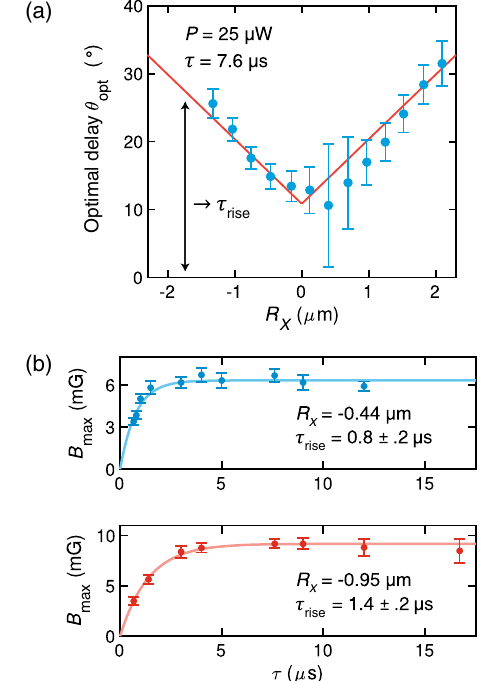
FIG. 5. Temporal dynamics of photo-Nernst current generation. (a) Dependence of the optimal delay θ on the coordinate R X for opt R 0 . The linear fit (solid line) indicates that for increasing Y ¼ j R X j , the photocurrent rise time τ rise becomes a larger fraction of τ , the duration of a single photoexcitation pulse. (b) Measured B versus the spacing τ of the synchronized photosensing max sequence for two different values of R X using P ¼ 38 μ W. Here, the repetition rate of the photoexcitation and NV driving pulses remain equal, but they change together. The rise time τ for rise B increases for larger j R X j , corroborating the trend in θ max opt shown in (d). The solid lines are exponential